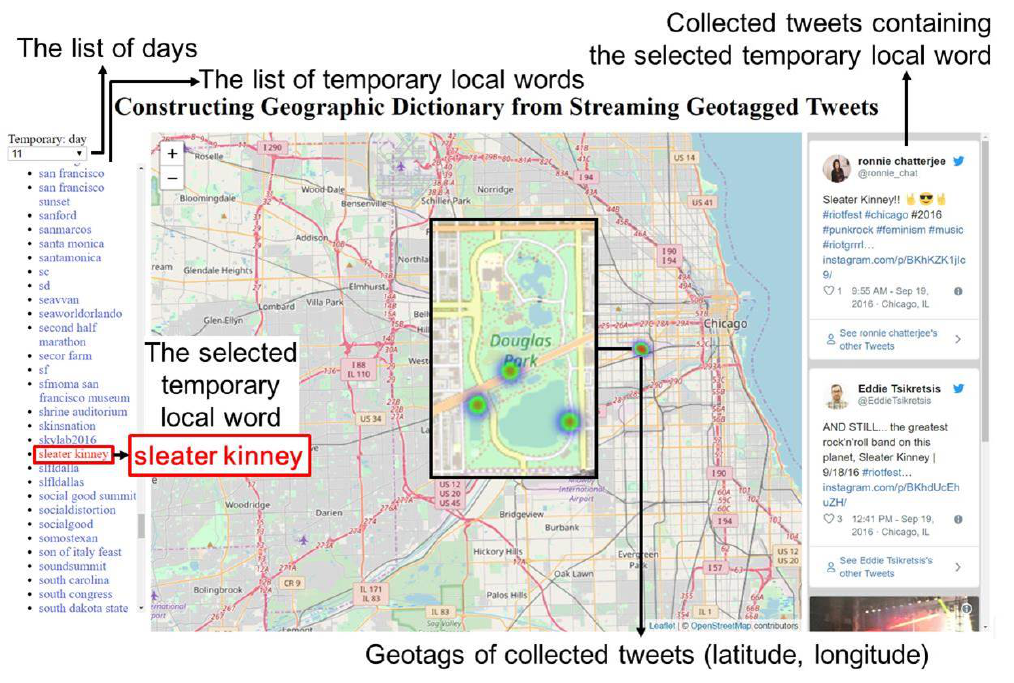
Figure 17. Visualization of collected geographic information.